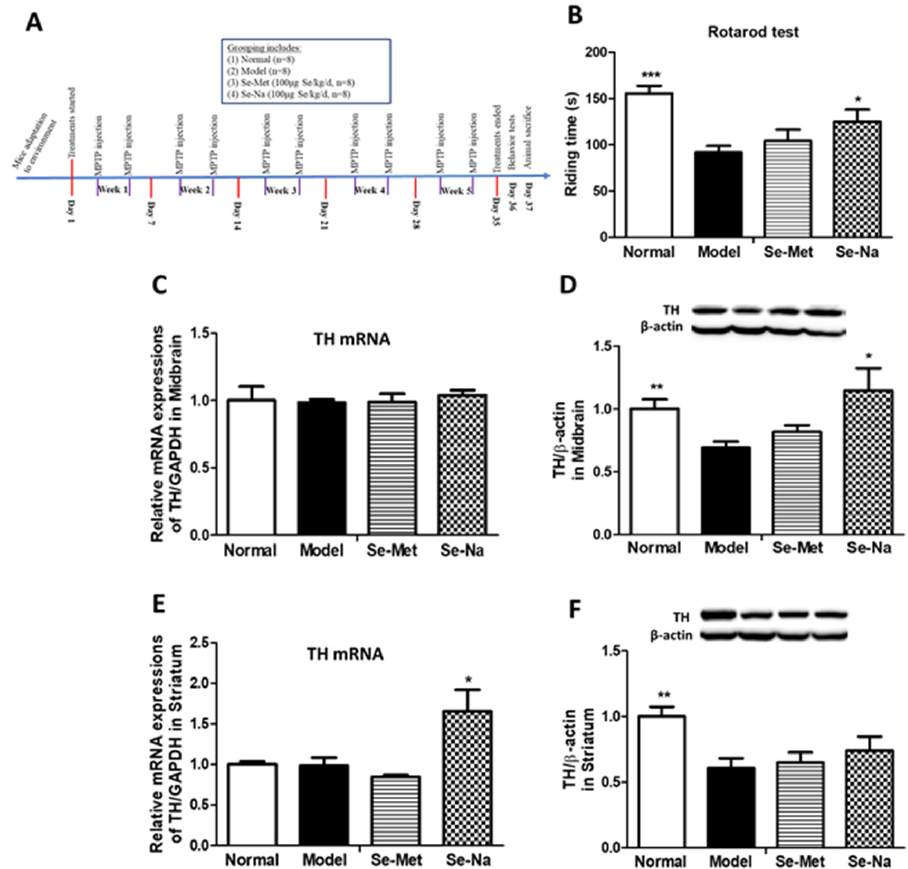
Figure 2. Comparative effects of Se-Na and Se-Met in chronic PD mice model. ( A ) Timeline of animal experiments. ( B ) Rotarod test of mice indicated by riding time on the rod(s). TH gene ( C , E ) and protein ( D , F ) expressions in the midbrain or striatum of mice in each group. TH mRNA expressions were shown as a quantitative ratio of TH to GAPDH gene and relative to the group mean of the Normal group. For protein expressions, one representative band for TH and endogenous β -actin from each group; and the following bar chart shows the ratio of TH/ β -actin in each group in the midbrain of mice. Values are expressed as mean ± SEM, n = 8. * p < 0.05, ** p < 0.01, *** p < 0.001 vs. Model group. Se-Na, sodium selenite; Se-Met, Seleno-L-methionine; PD, Parkinson’s disease; TH, tyrosine